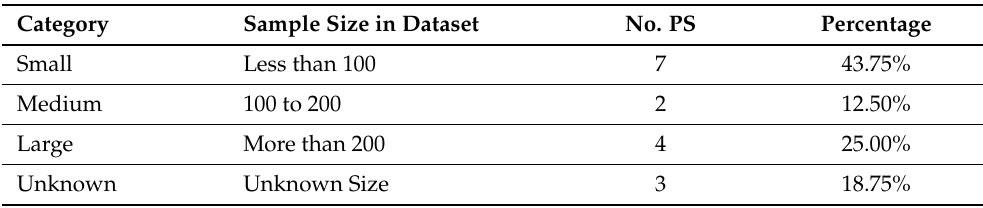
Table 7. Category of datasets based on the number of projects.